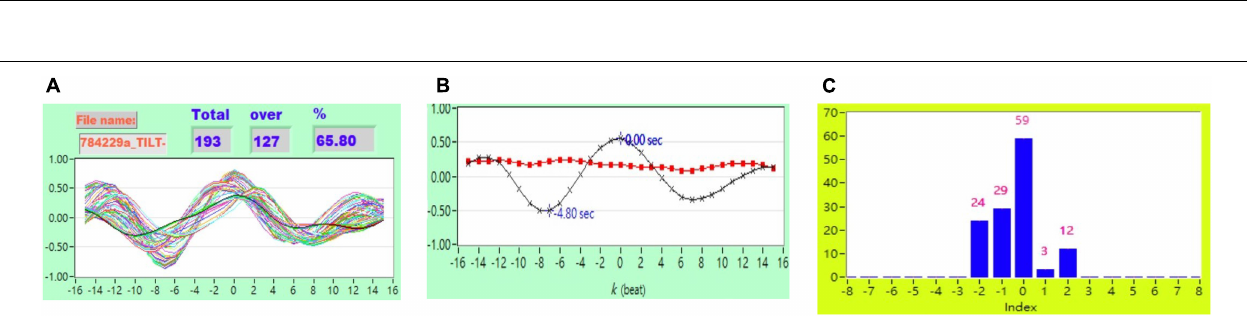
FIGURE 3 | (A) Representative plot of CCF curves with thresholding [–5 (cid:53) k (cid:53) 5 and CCF(k) > 0], (B) mean CCF value ( x ) and SD ( (cid:4) ), and (C) distribution bar chart of maximum CCF index during tilt in a healthy subject.